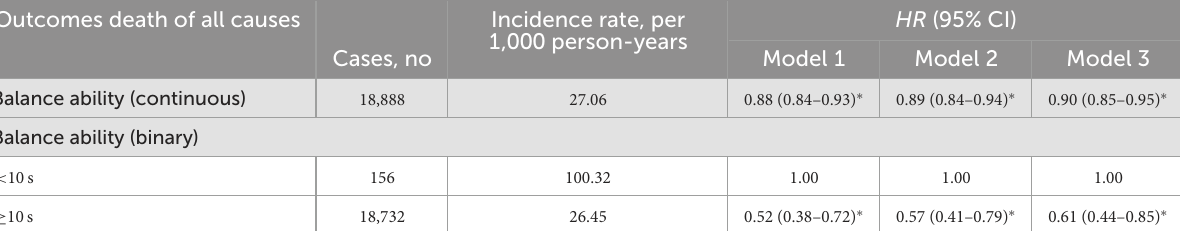
TABLE 2 Construction of Cox proportional hazards model for balance ability to